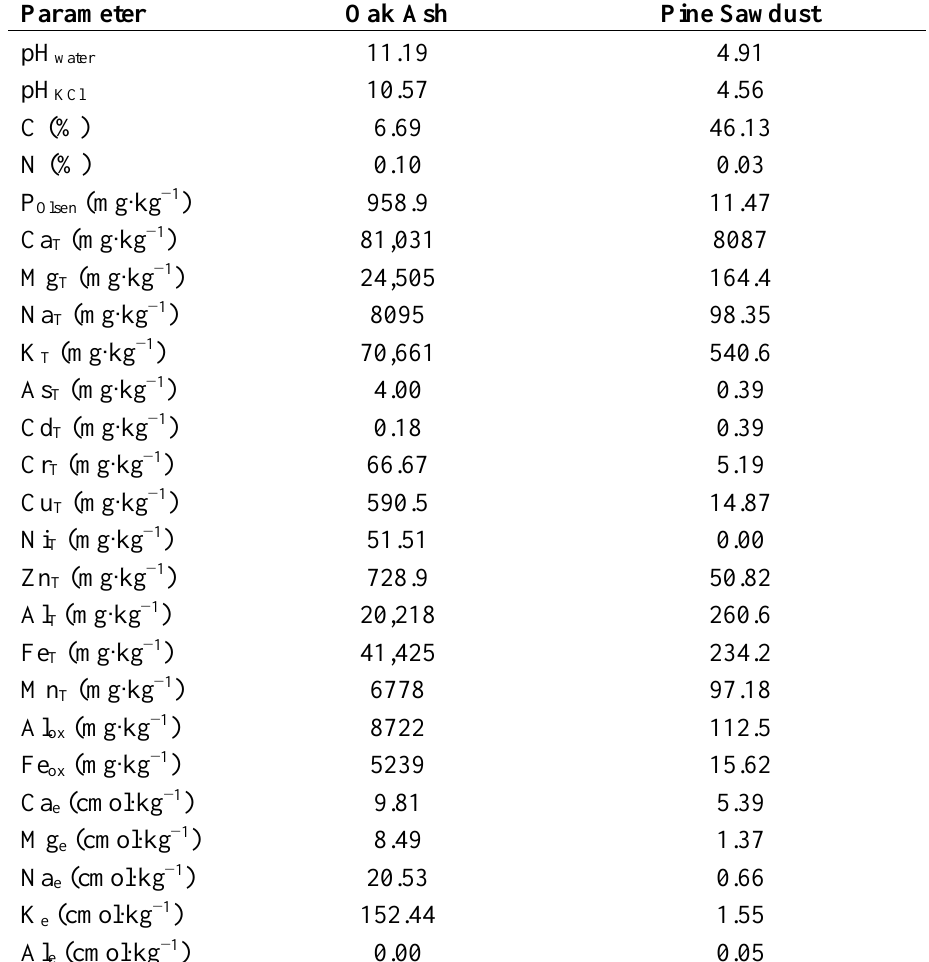
Table 1. General characteristics of the adsorbent materials: oak wood ash and pine sawdust (average values of 3 replicates; the coefficients of variation were <5% in all